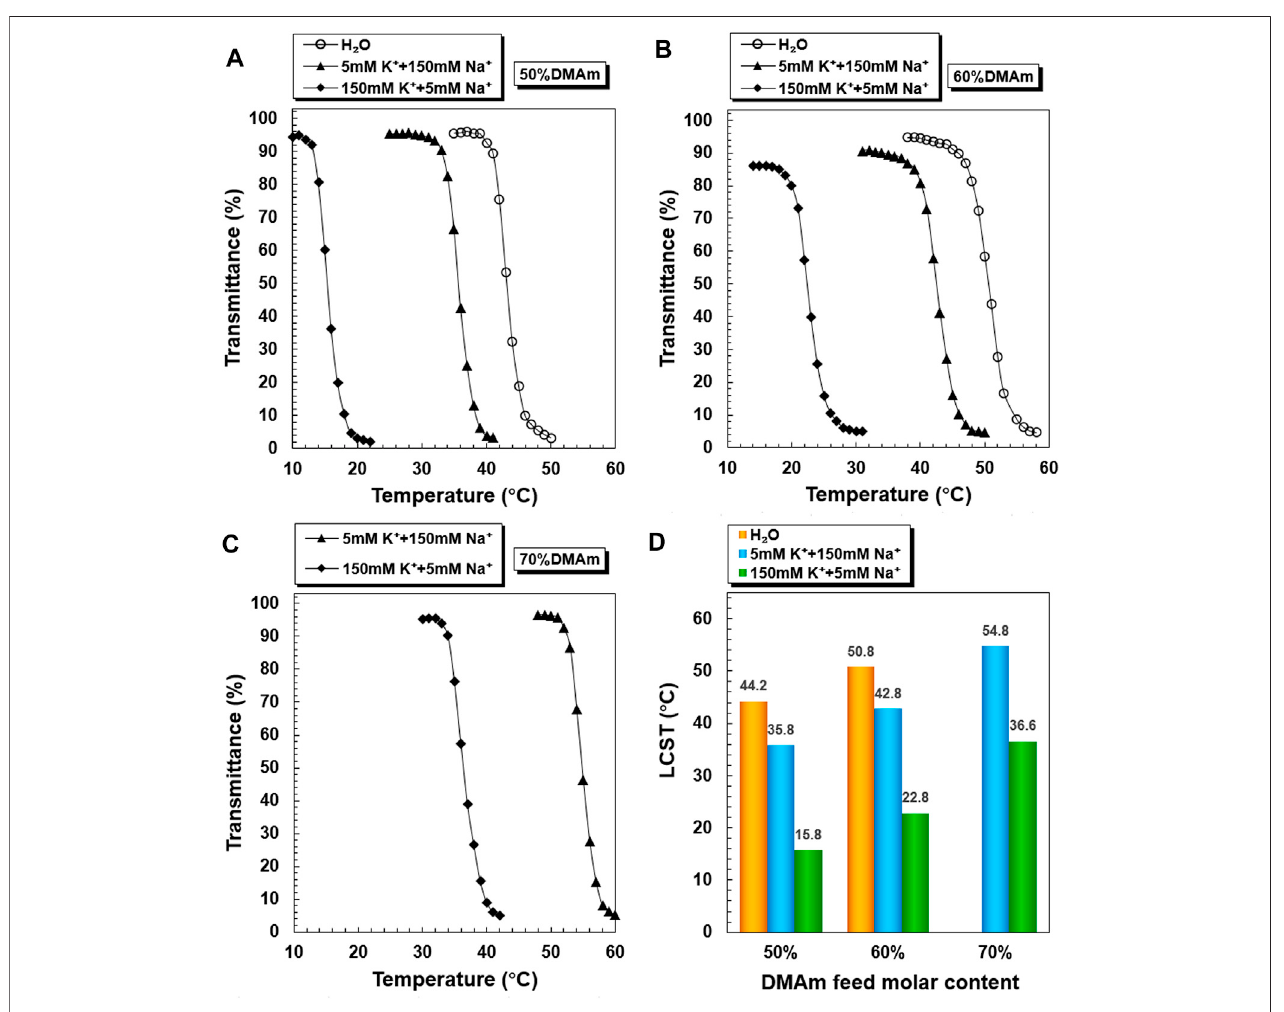
FIGURE 3 | K + -responsive behaviors of PNDB-b-DSPE block copolymers. Temperature-dependent phase transition behaviors of PNDB-b-DSPE1 (A) , PNDB-b- DSPE2 (B) , and PNDB-b-DSPE3 (C) copolymer solutions with different K + concentration levels. LCST values of PNDB-b-DSPE1, PNDB-b-DSPE2, and PNDB-b- DSPE3 copolymer solutions with different K + concentration